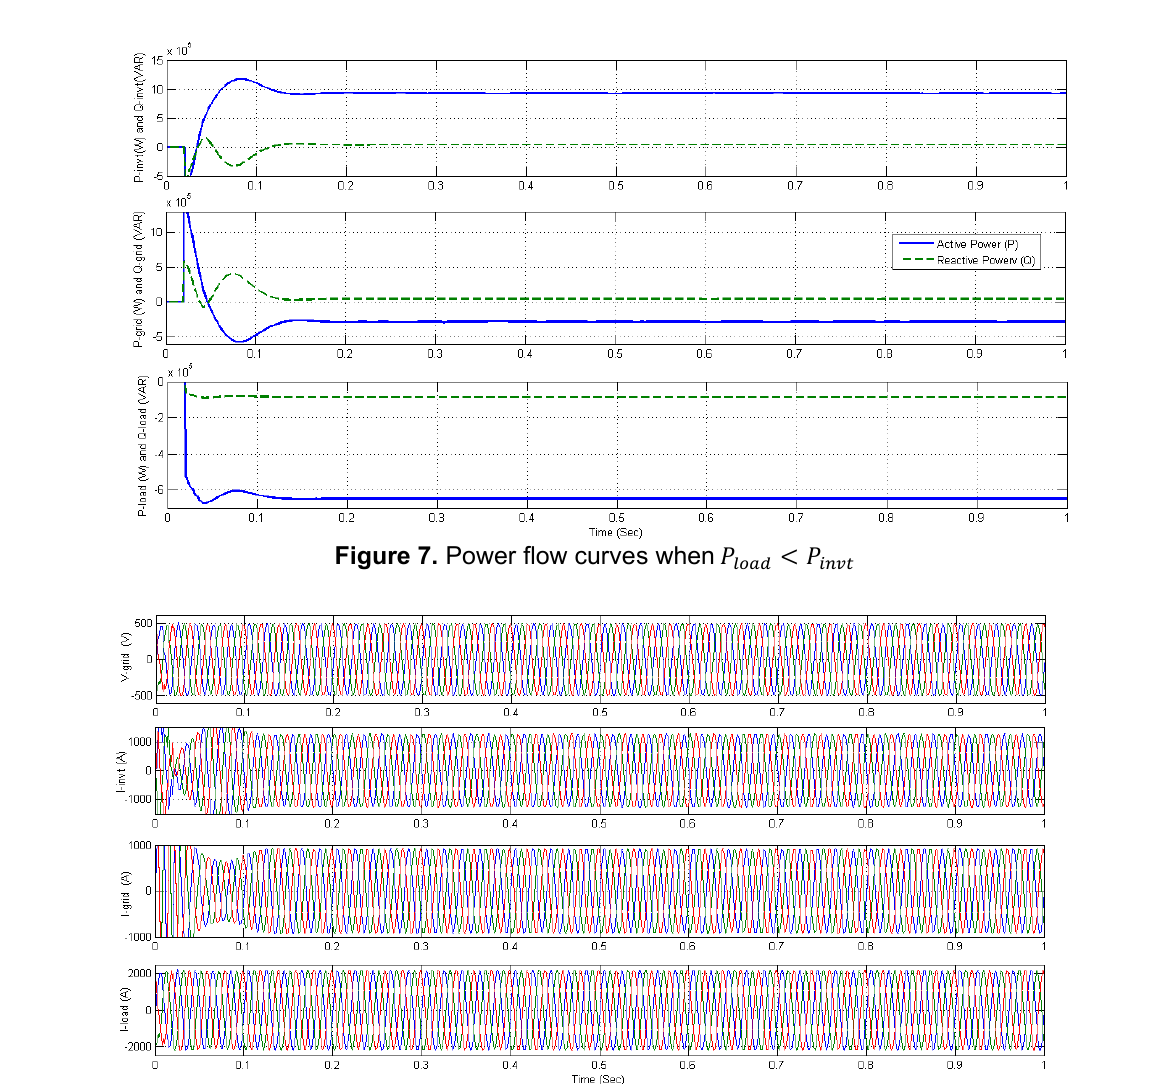
Figure 8. Grid performance when